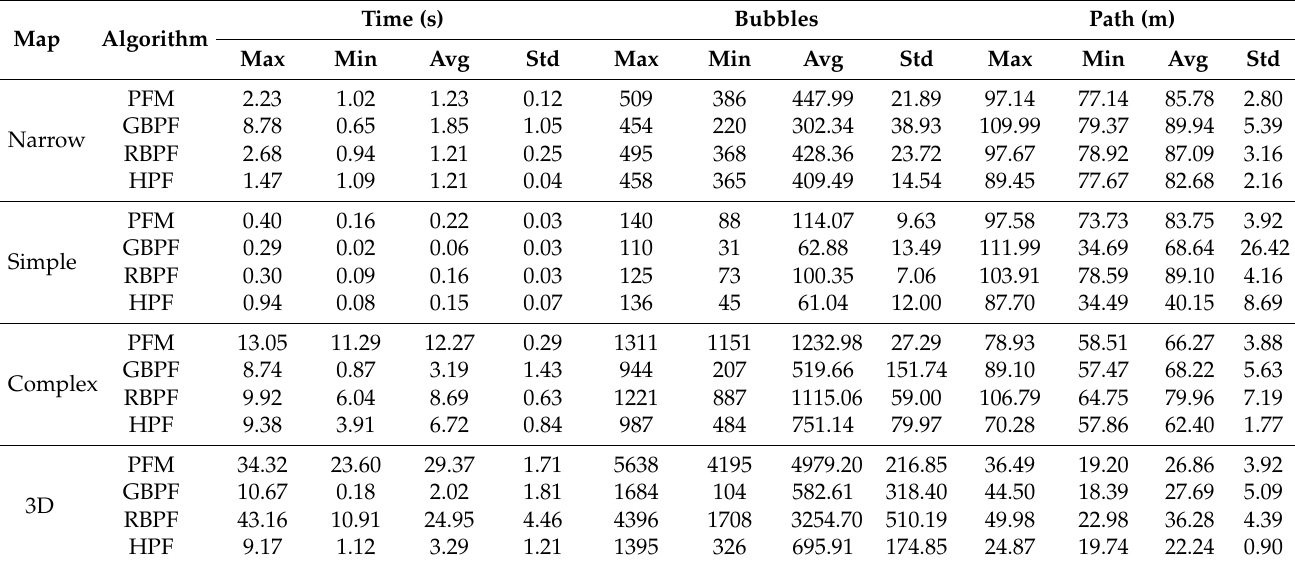
Table 2. Numerical results of processing time, number of bubbles, and path length for multiple simulations with the algorithms for all